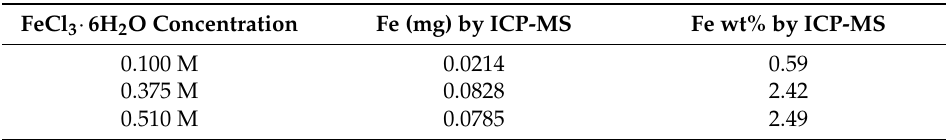
Table 1. ICP-MS analysis results for the Fe content in the SiO 2 @Fe/SiO 2 composite spheres prepared with different concentrations of iron(III) chloride